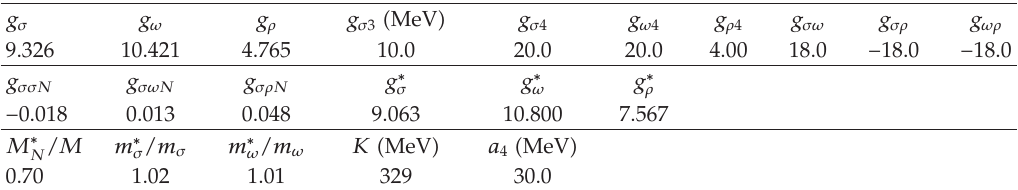
Table 1: Properties of nuclear matter and (cid:7) n,p, Σ − ,e (cid:8) , (cid:7) n,p, Λ ,e (cid:8) neutron stars. The properties of symmetric nuclear matter connected with isospin-asymmetric, beta-equilibrium matter (cid:7) n,p,e (cid:8) whose EOS produces M max (cid:7) n,p,e (cid:8) (cid:5) 2 . 50 M (cid:2) are listed. The coupling constants are chosen from the data NHA 2 . 50 in the paper (cid:3) 20, 21 (cid:4) .